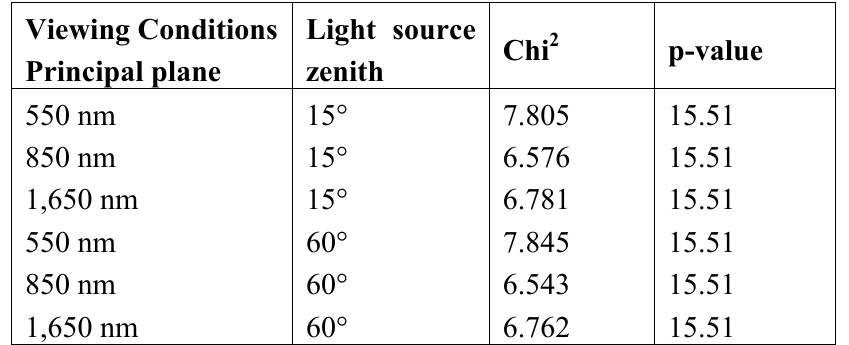
Table 2. Chi 2 and p values for a significance level α = 0.05 for three wavelengths and two light source zenith positions. The p-value for 8 degrees of freedom (9 sensor zenith positions) is